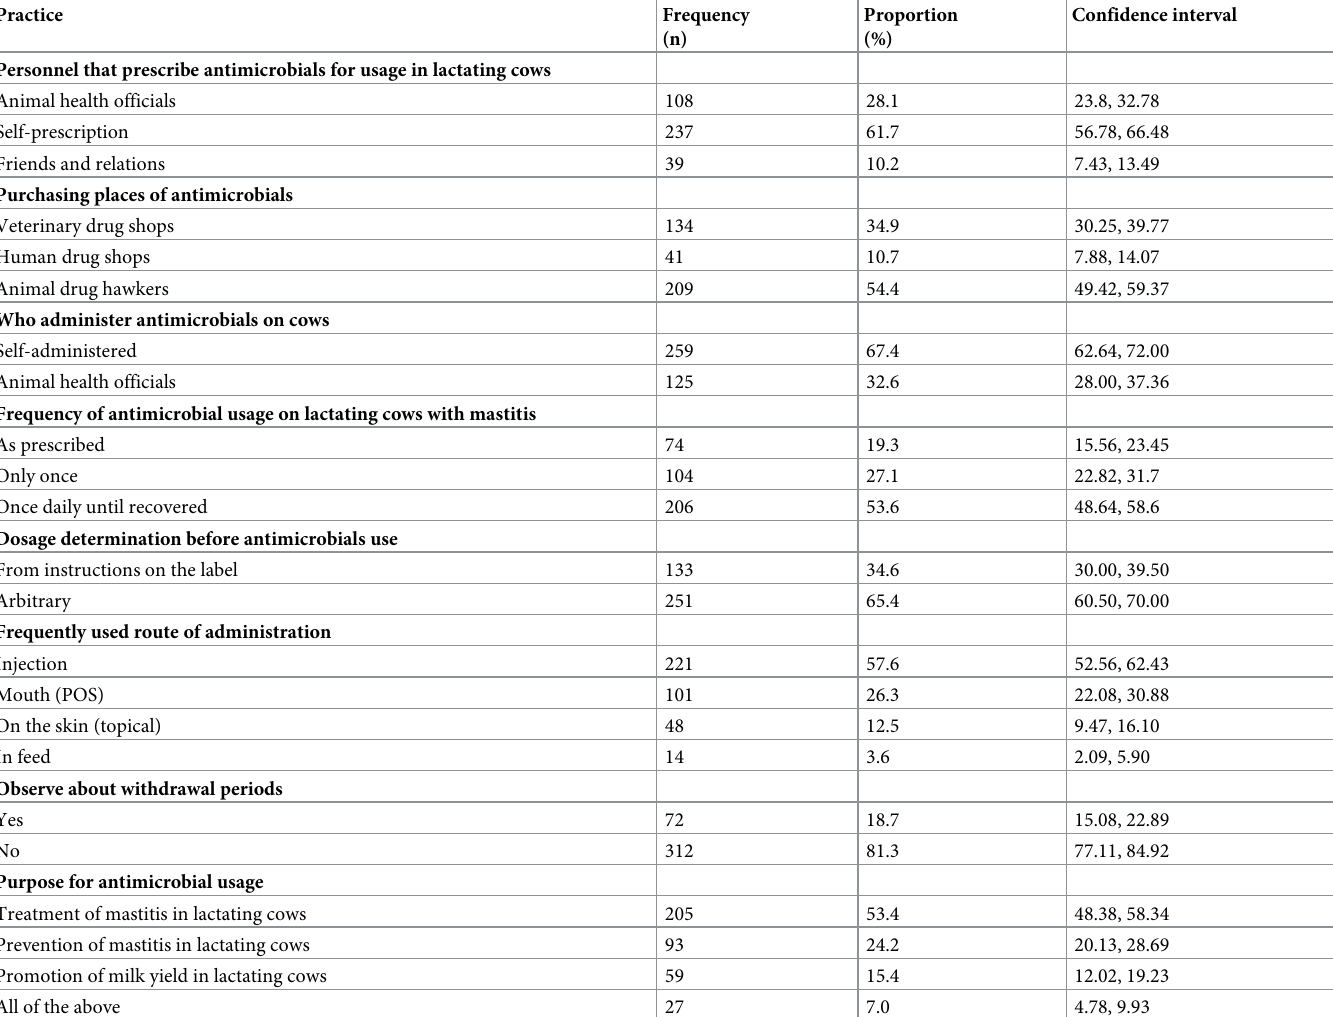
Table 2. Practices of antimicrobial usage on lactating cows by Fulani pastoralists in North-central Nigeria.